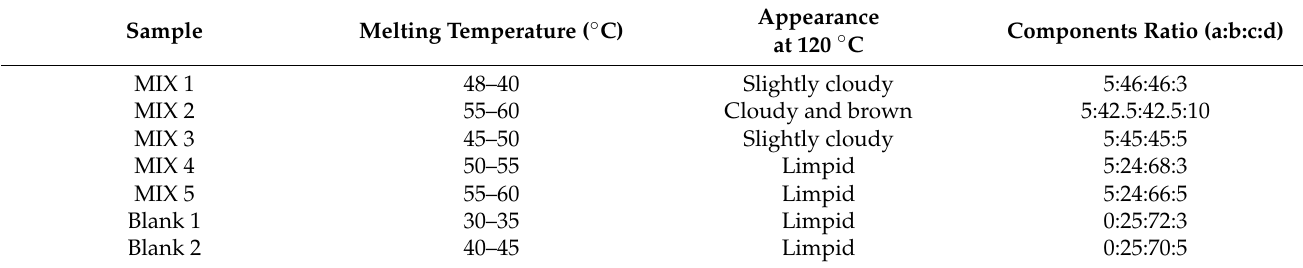
Table 5. Evaluation of the tested lipid mixtures in terms of melting temperature range and appearance of the melted mass.